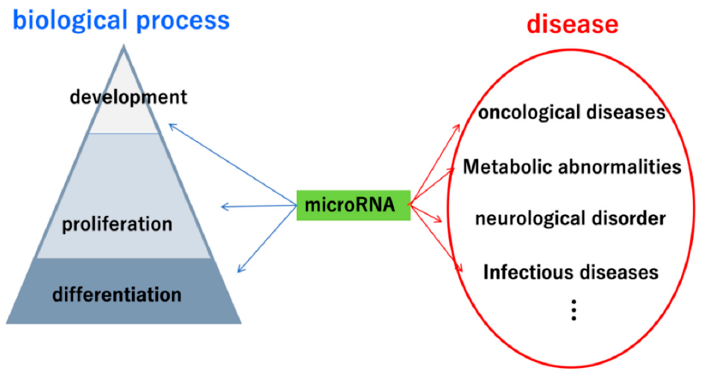
Figure 1. Involvement of miRNAs in physiological processes and diseases. miRNAs are involved in life processes such as development, proliferation, and differentiation. They are also involved in the processes of diseases such as cancer, metabolic disorders, neurological disorders, and infectious